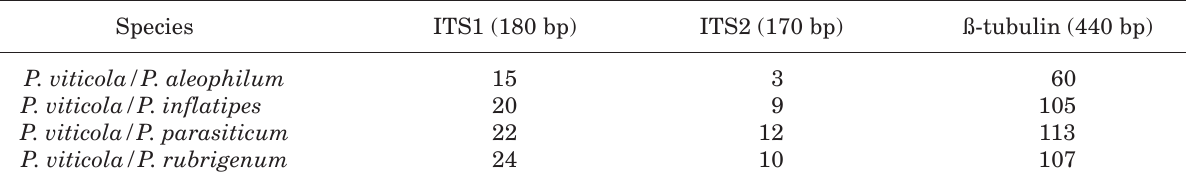
Table 2. Nucleotide differences between Phaeoacremonium viticola and other species of the genus within ITS and partial ß-tubulin sequences. Type strain of each species was used (see Table 1).